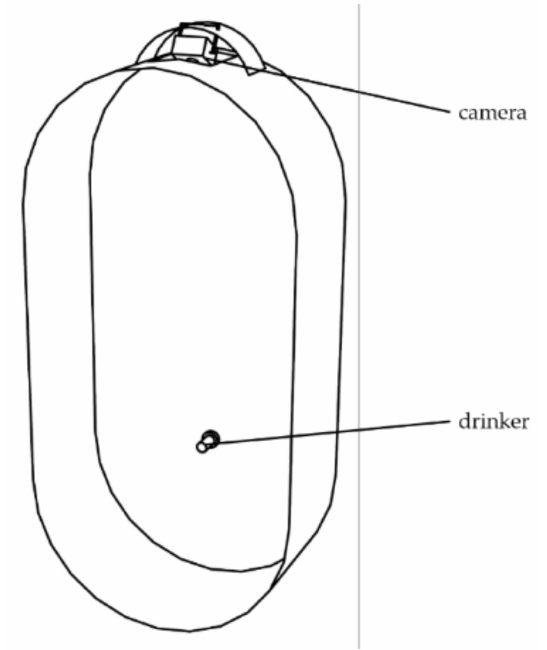
Figure 2. Drinking behavior acquisition and recognition system.